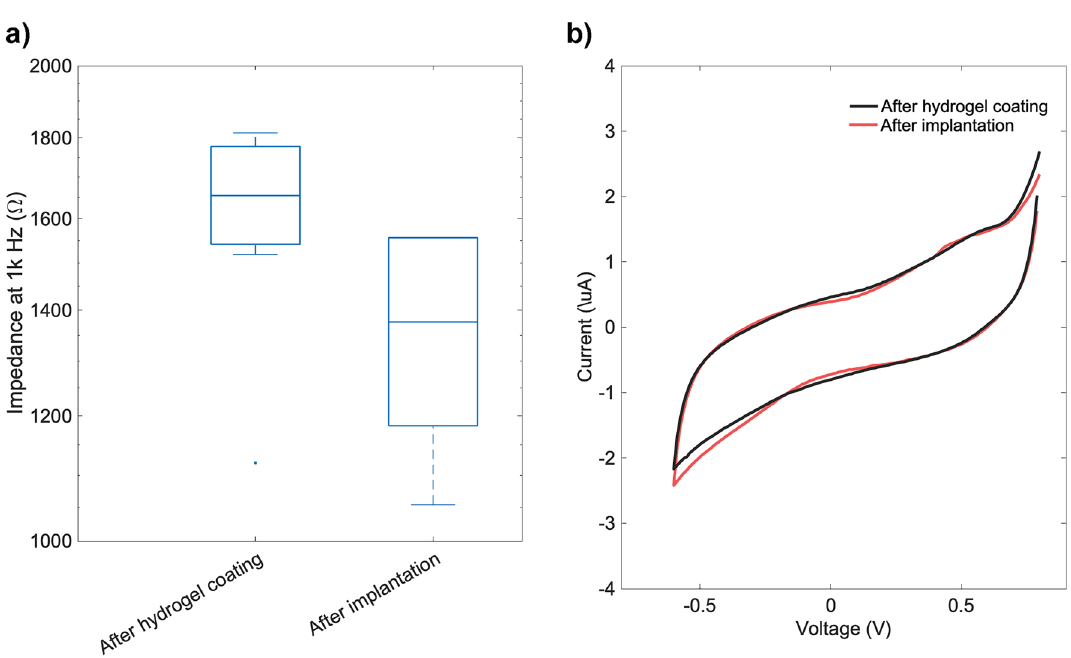
Figure 7. Impedance characterization of electrodes (n = 6). ( a ) A box-and-whisker plot demonstrates the impedance of electrodes at 1 kHz after hydrogel coating and after implantation. The box represents the range of data between the first and the third quartile, and the whiskers represents the maximum and minimum data points without outliers (labeled in dots). The solid line inside the box is the median value. ( b ) CV curve of one electrode shows CV after hydrogel coating in black and after implantation in